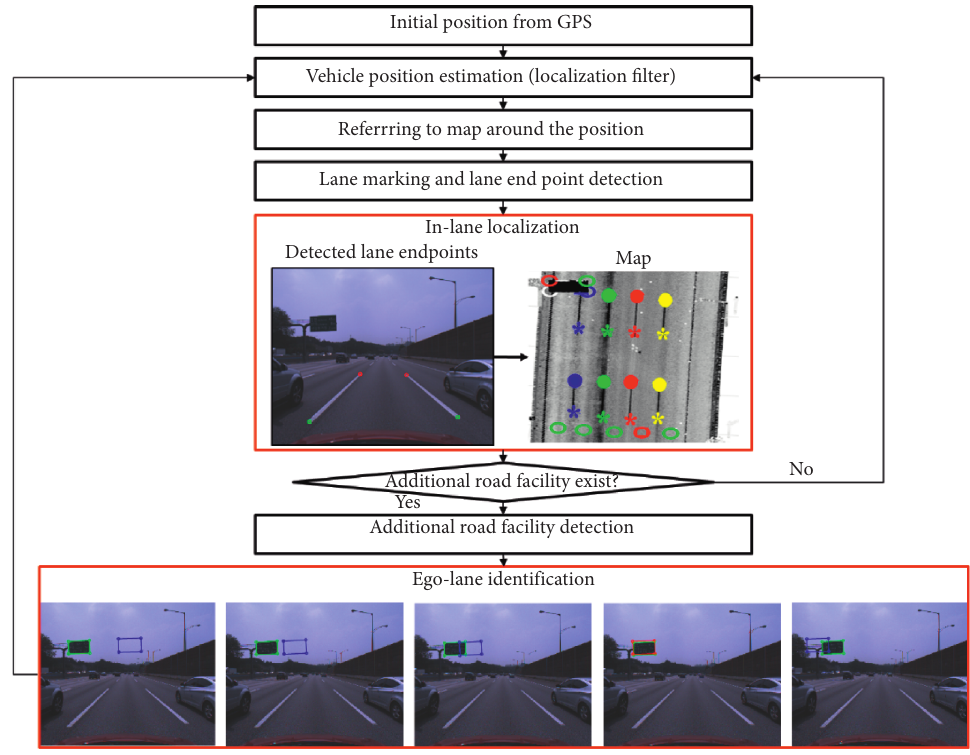
Figure 2: System